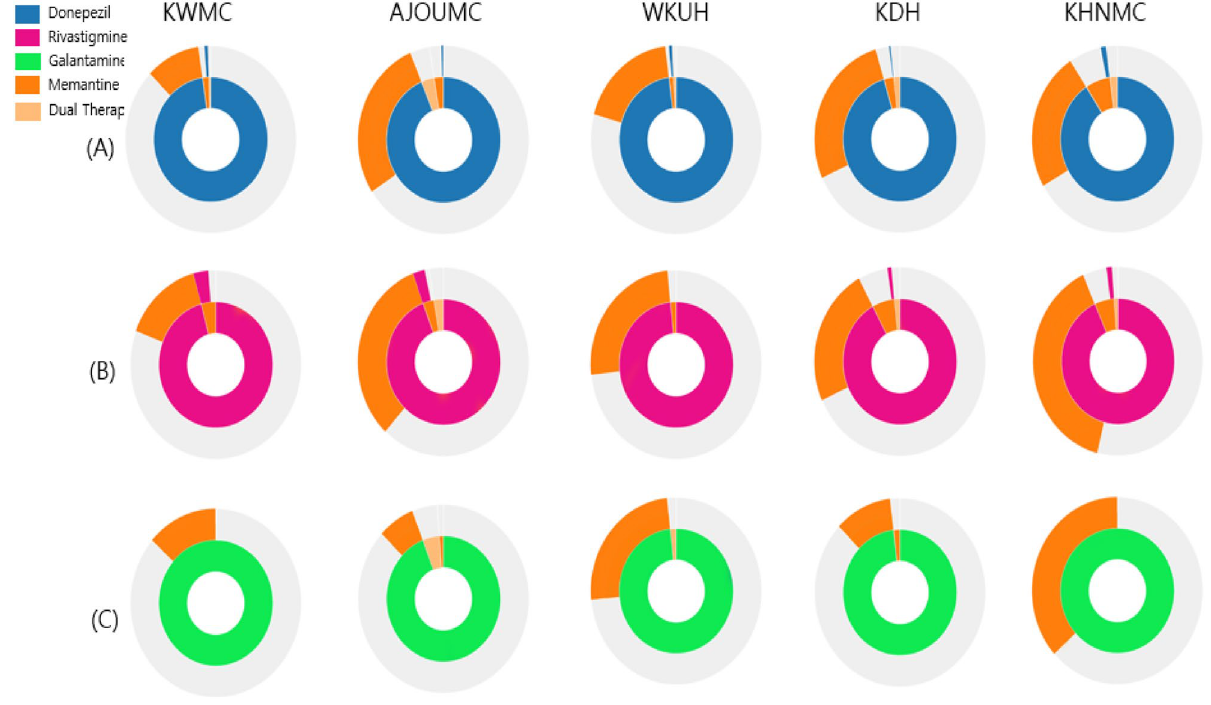
Figure 5. Treatment pathway for each choline esterase inhibitor group combined with NMDA receptor antagonist from database of each hospital. Donepezil ( A ), rivastigmine ( B ) and galantamine ( C ), the inner circle shows the first medication that the patient took, the second circle revealed the second medication.